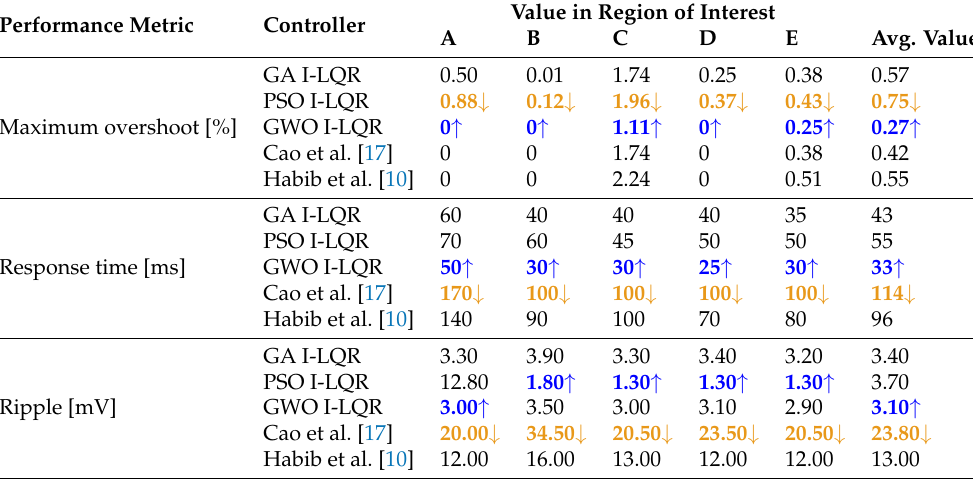
Figure 14. Settling time and overshoot of IBC controllers. Table 6. Performance metrics for all the controllers generated for the IBC in the different regions of interest. Blueish and yellowish values represent the best and worst metrics in each region,